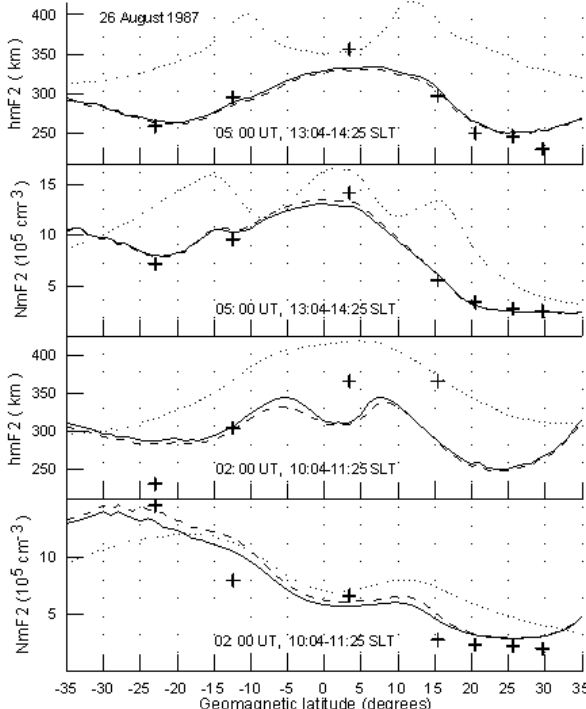
Fig. 13. Observed (crosses) and calculated (lines) hmF 2 and NmF 2 at 08:00 UT (two lower panels) and 11:00 UT (two upper panels) on 25 August 1987. The measured hmF 2 and NmF 2 are taken from the ionospheric sounder station listed in Table 1. The curves are the same as in Fig. 12.